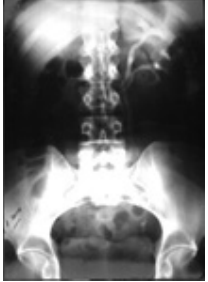
FIGURE 4. Identical twin sister of patient shown in Figure 3, demonstrating ipsilateral absence of right kidney. Note partial duplication of